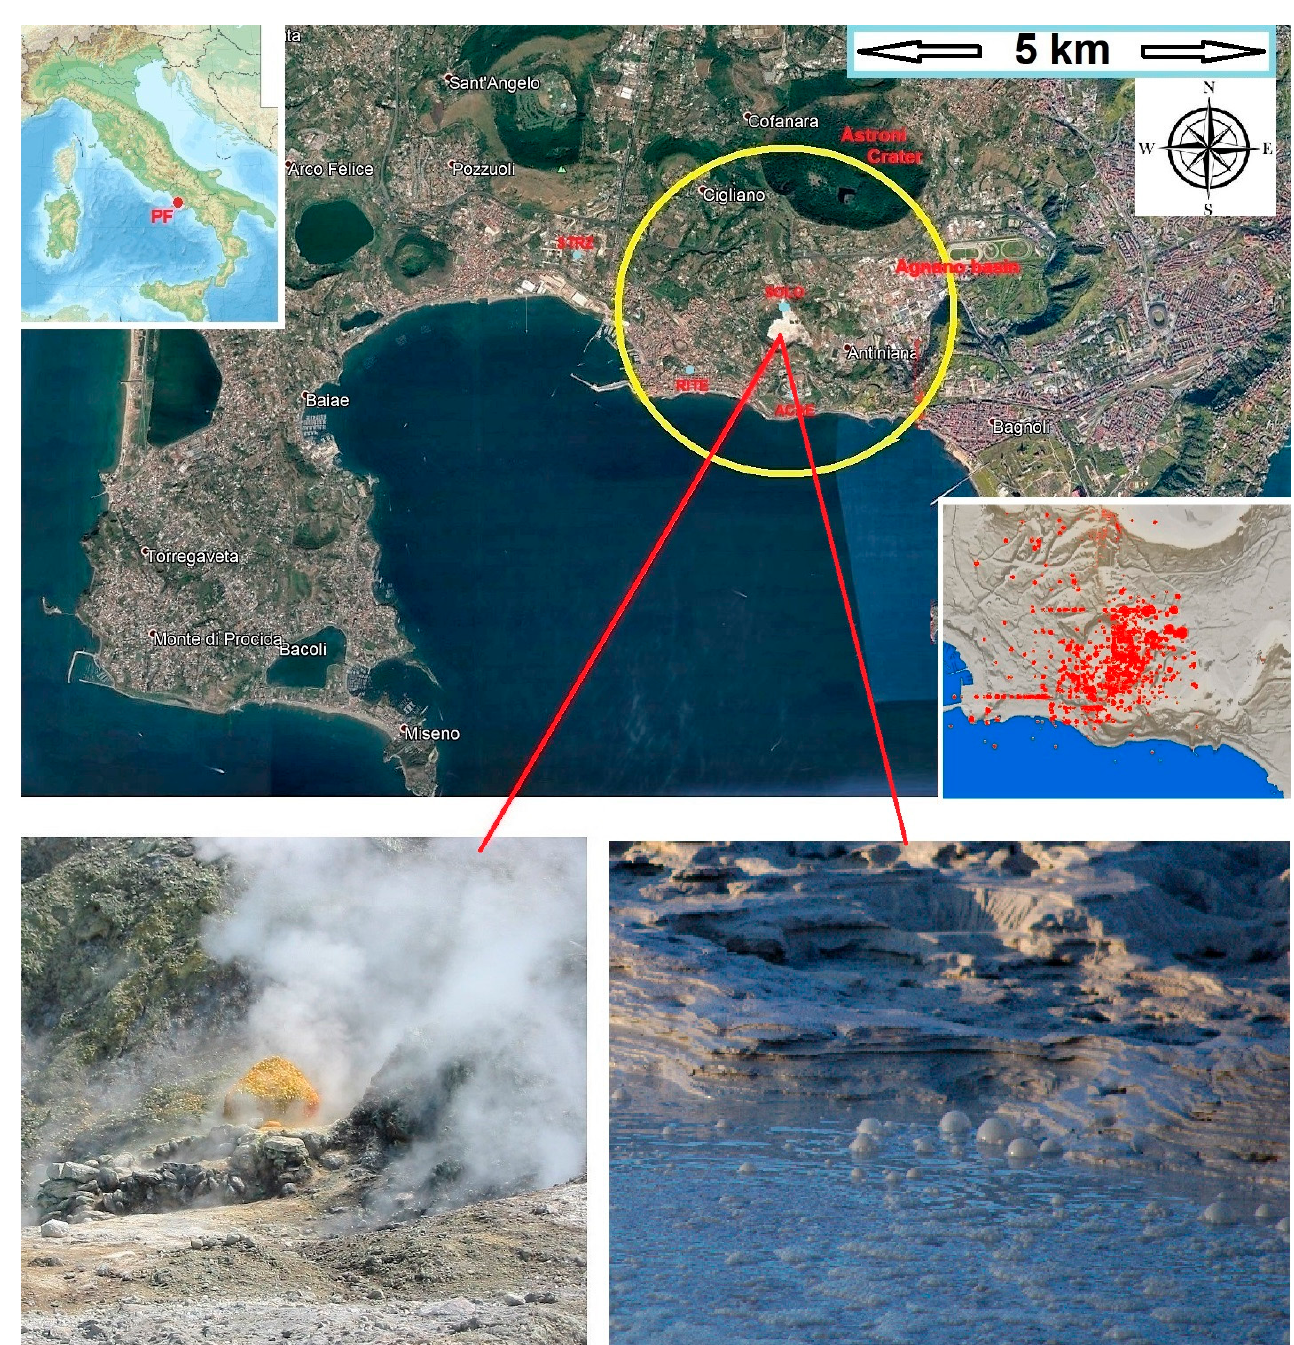
Figure 1. ( Top ) The Phlegraean Fields (PF) area, with the most seismic region highlighted (yellow circle) (modified from Google Earth Pro). The events that occurred in 2020 are shown in the right insert against the digital terrain model of the area (modified from INGV-OV: http://www.ov.ingv.it, © CC BY-NC-ND 4.0). ( Bottom-left ): The fumarolic field at the Solfatara (https://en.wikipedia.org/wiki/Solfatara_(volcano), © CC BY-SA 3.0). ( Bottom-right ): Close-up view of a boiling mud pool at the Solfatara (https://en.wikipedia.org/wiki/Solfatara_(volcano), © CC BY-SA 4.0). The seismicity of the Phlegraean Fields has been related to its bradyseism since ancient times [2,23]. Bradyseism is the gradual uplift or descent of a terrain area induced by